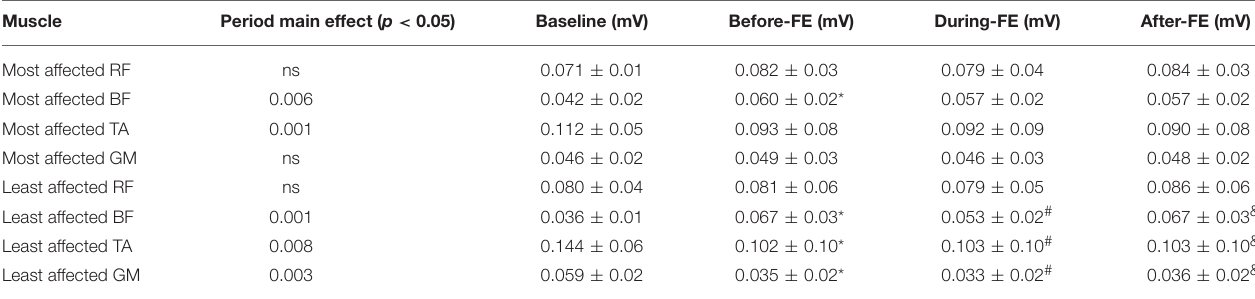
TABLE 2 | RMS amplitudes (Group means ± SD) during stepping-in-place task across four periods in individuals with Parkinson’s disease who experienced freezing in the study.